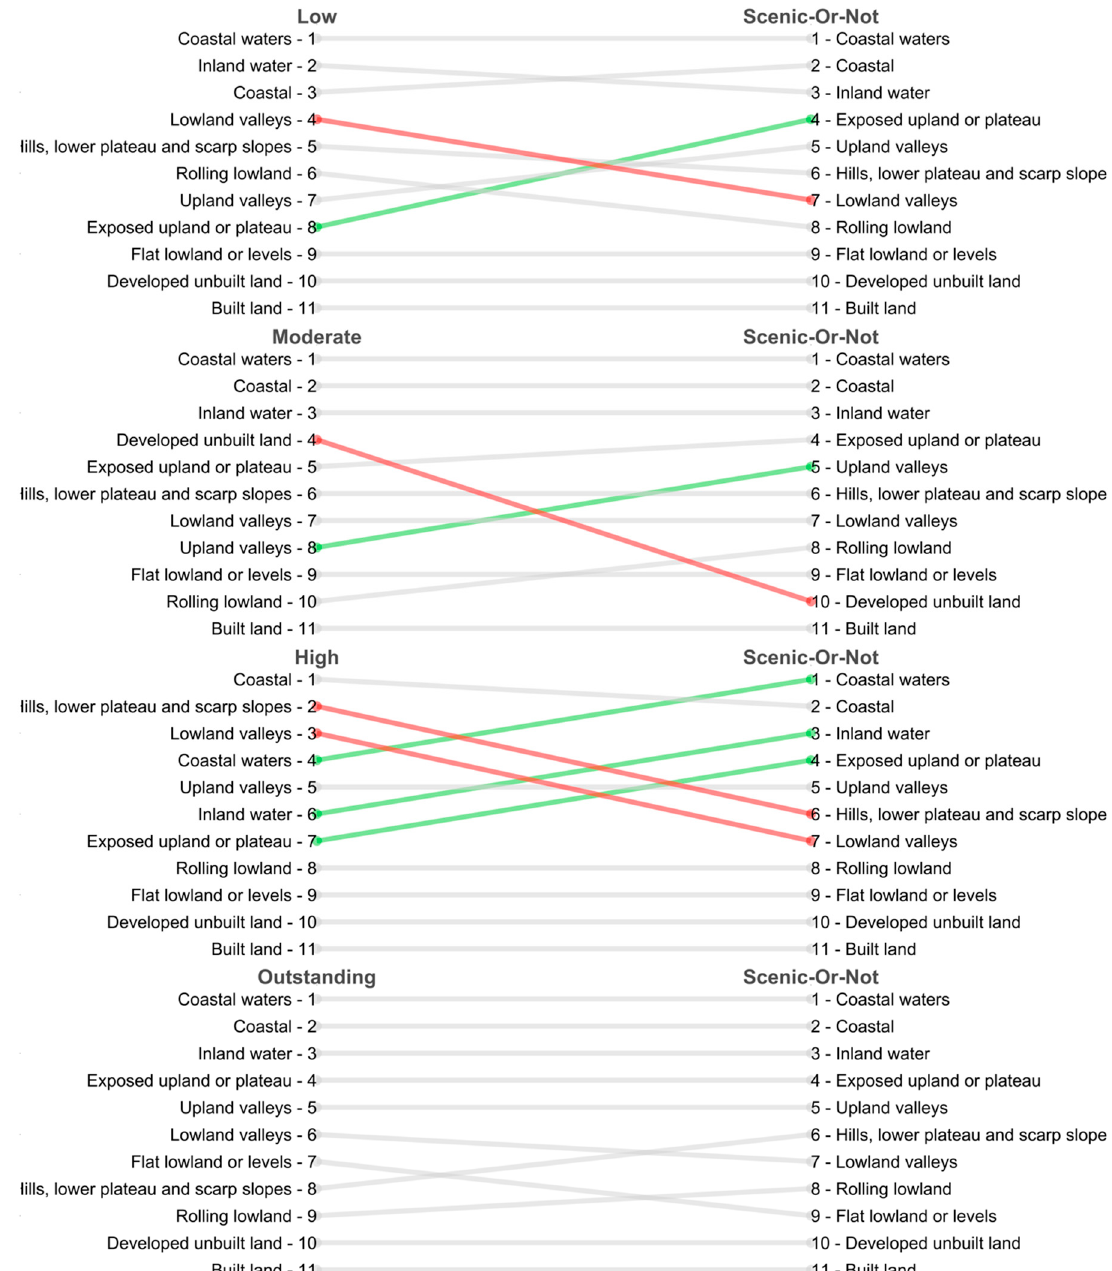
Figure 4. Landform rankings of scenic quality were compared between experts and non-experts, based on the results of the four GLMs and the OLS. The larger rank differences are highlighted where changes of greater than 3 or less than 3 are coloured green and red, respectively, and the rest are shown in grey.